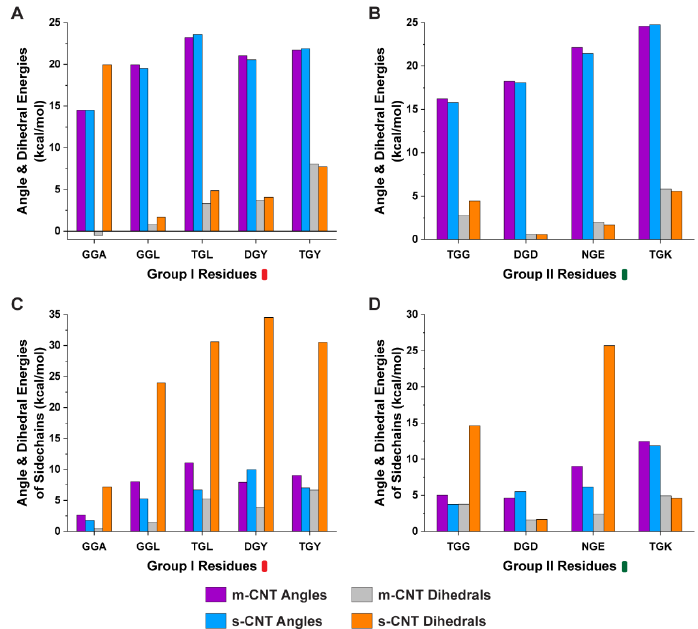
Figure 5. Conformational energies in terms of angle and dihedral energies for ( A , B ) tripeptide com- binations and ( C , D ) sidechains of the tripeptides for groups I and II with respect to metallic and semiconducting CNTs.